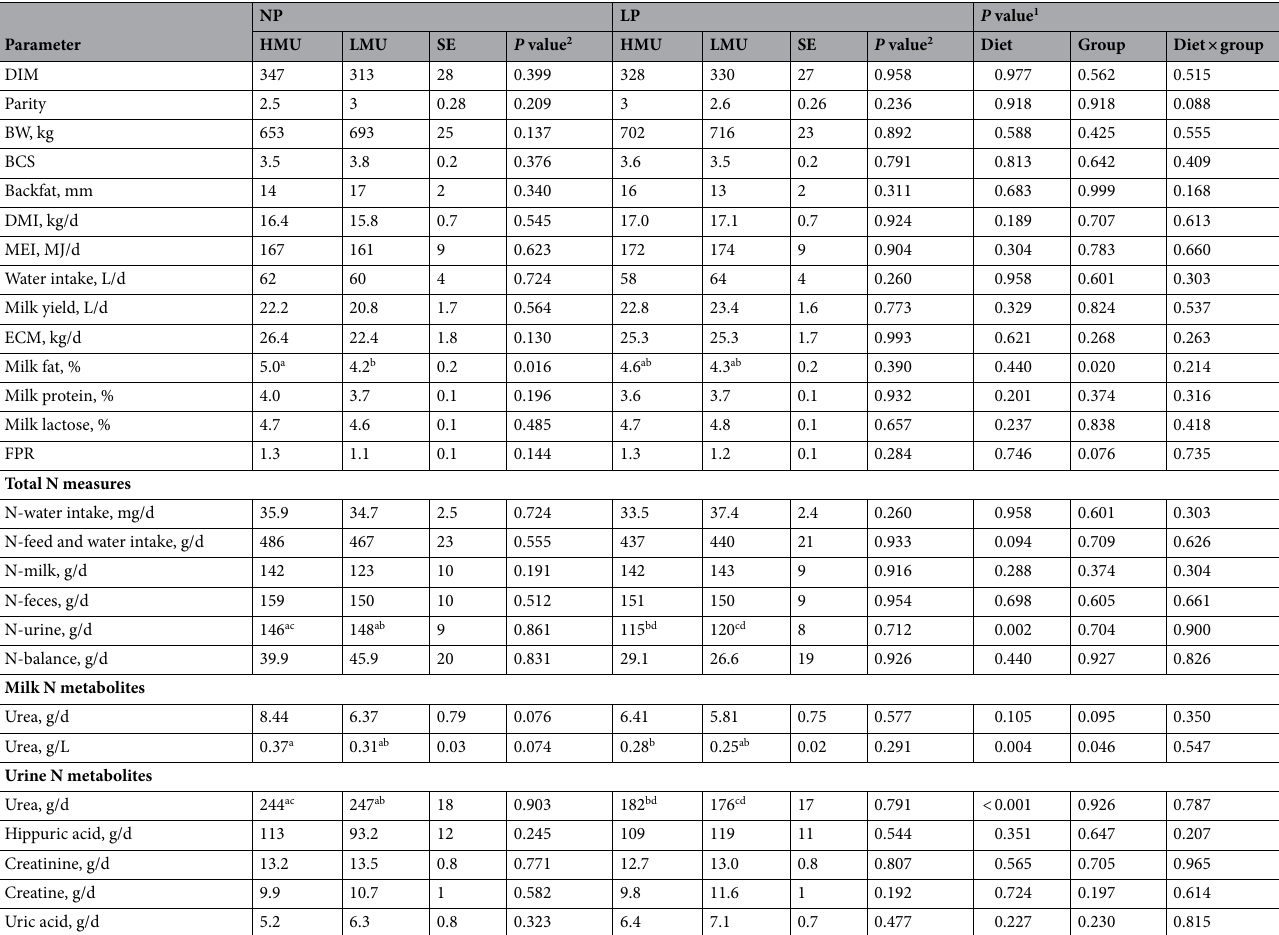
Table 2. Animal characteristics, nitrogen intake and excretion of dairy cows with high (HMU) and low milk urea concentration (LMU) fed a normal (NP) and a low dietary crude protein level (LP) under conditions of interval feeding (97% of ad libitum intake). Data are given as least square means and standard error (SE). a-d Different superscript letters within one row indicate P < 0.05 (Tukey-test). DIM: days in milk; DMI: dry matter intake; MEI: metabolizable energy intake; ECM: energy corrected milk; FPR: milk fat% -to-milk protein%-ratio. 1 P value from ANOVA analysis. 2 P value from Tukey slice